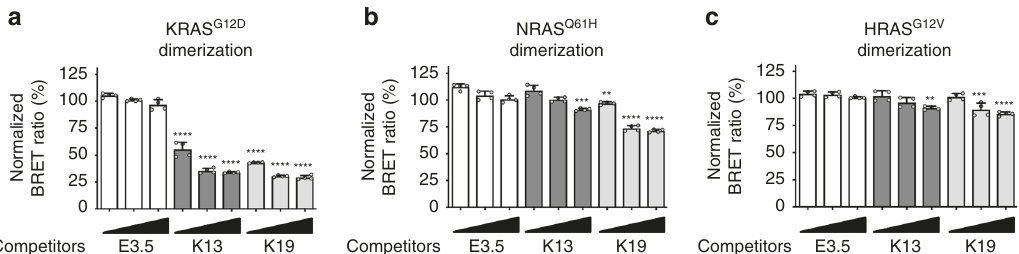
Fig. 7 K13/K19 selectively prevent KRAS dimerisation. BRET competition assays with homodimerisation of ( a ) KRAS G12D ; ( b ) of NRAS Q61H and ( c ) of HRAS G12V using DARPins K13 or K19 as competitors and DARPin E3.5 as non-binding negative control. Statistical analyses in a – c were performed using a one-way ANOVA followed by Dunnett ’ s post-hoc tests (** P < 0.01, *** P < 0.001, **** P < 0.0001). Each experiment was performed four times ( a – c ). Error bars are mean ± SD of biological repeats. a – c Source data are provided as a Source Data fi